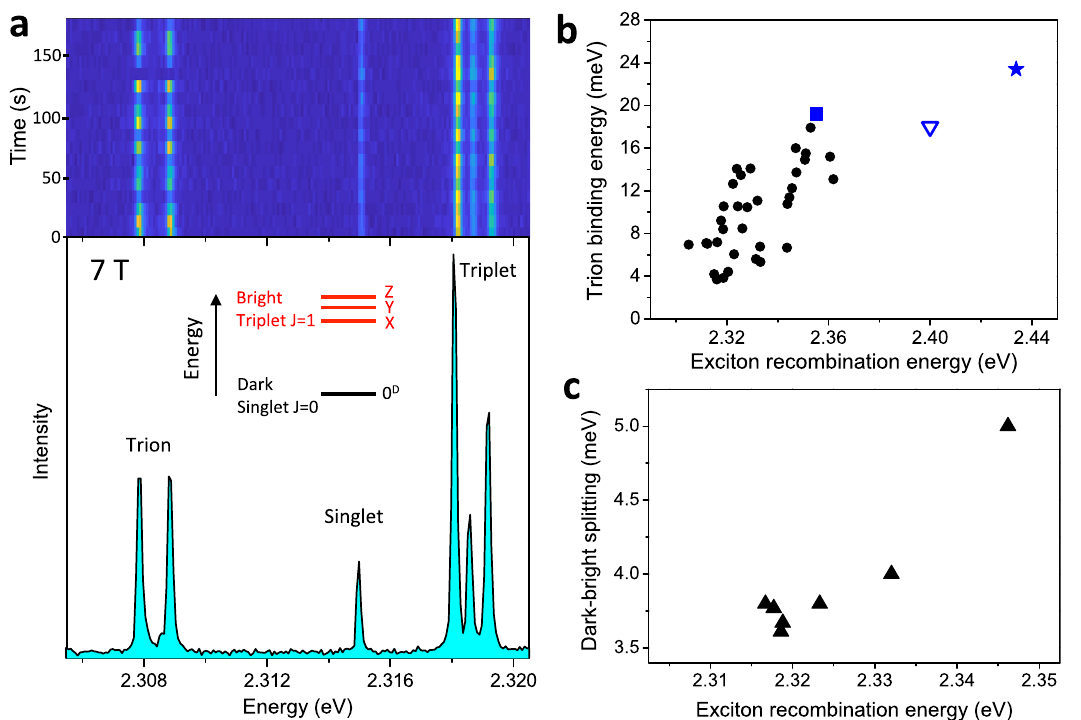
Fig.2|Band-edgeexciton fi nestructureandtrionbindingenergyinCsPbBr 3 NCs. a The upper panel shows the spectral trail of a single NC at 7T, showing switches between the entire exciton fi ne structure manifold (triplet + singlet) and the trion Zeemandoublet.Thesingletandtripletlinesclearlyundergoidenticalvariationsof theirPLintensities.Theintensityvariationsofthedoubletandtheexcitonmanifold are anti-correlated, showing evidence that they belong to different charge com- plexes of the same NC. The lower panel displays the spectrum integrated over the spectral trail. The inset indicates the band-edge exciton fi ne-structure sublevels,